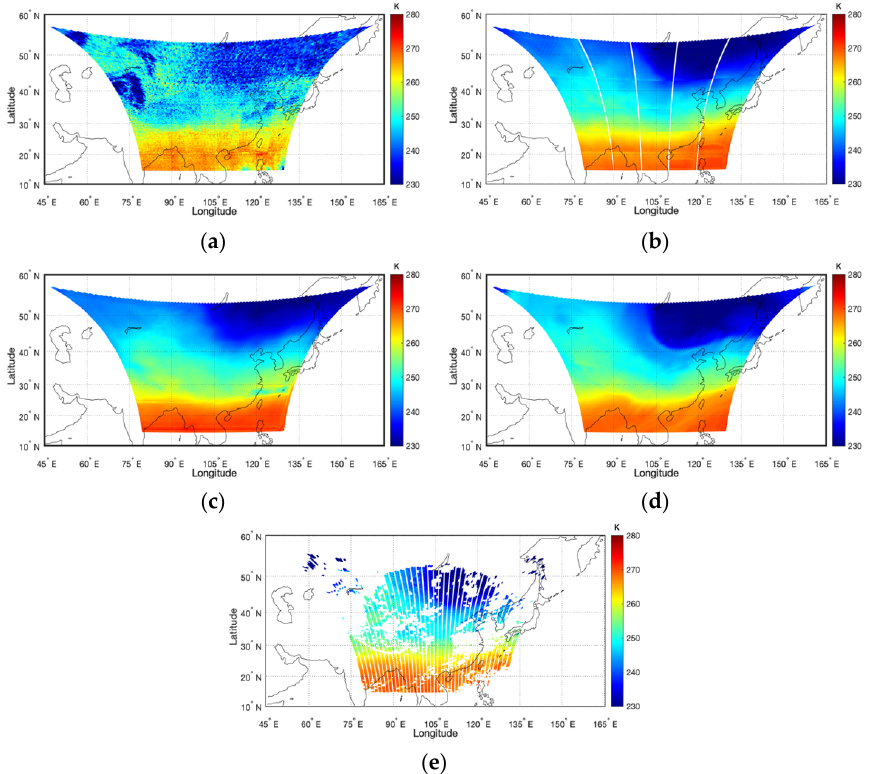
Figure 7. Same as Figure 6 except for 500 hPa: ( a ) 1D ‐ Net; ( b ) U ‐ Net 1; ( c ) U ‐ Net 2; ( d ) ERA5; ( e ) Level 2 product.